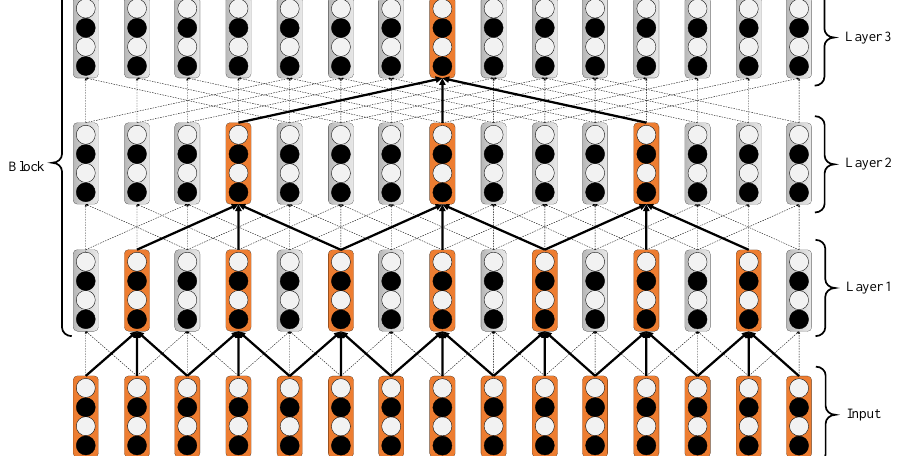
Figure 5. A dilated CNN block. The input is a sequence of texts, each of which is the word representation of Figure 2 (for example, 15 words are entered). The circles just represent the concept of dimensions. Layer 1 has a coefficient of expansion of 1 to obtain a receptive field of 3. Layer 2 expands by 1 on the basis of Layer 1; although the receptive field in Layer 2 is still 3, the receptive field in the input is 7. Take the orange unit of Layer 3 as an example: all related neurons are connected by thick lines, and the receptive field is 15. Each unit of each layer is connected to the three units of the previous layer; the number of parameters remains unchanged, but the receptive field increases